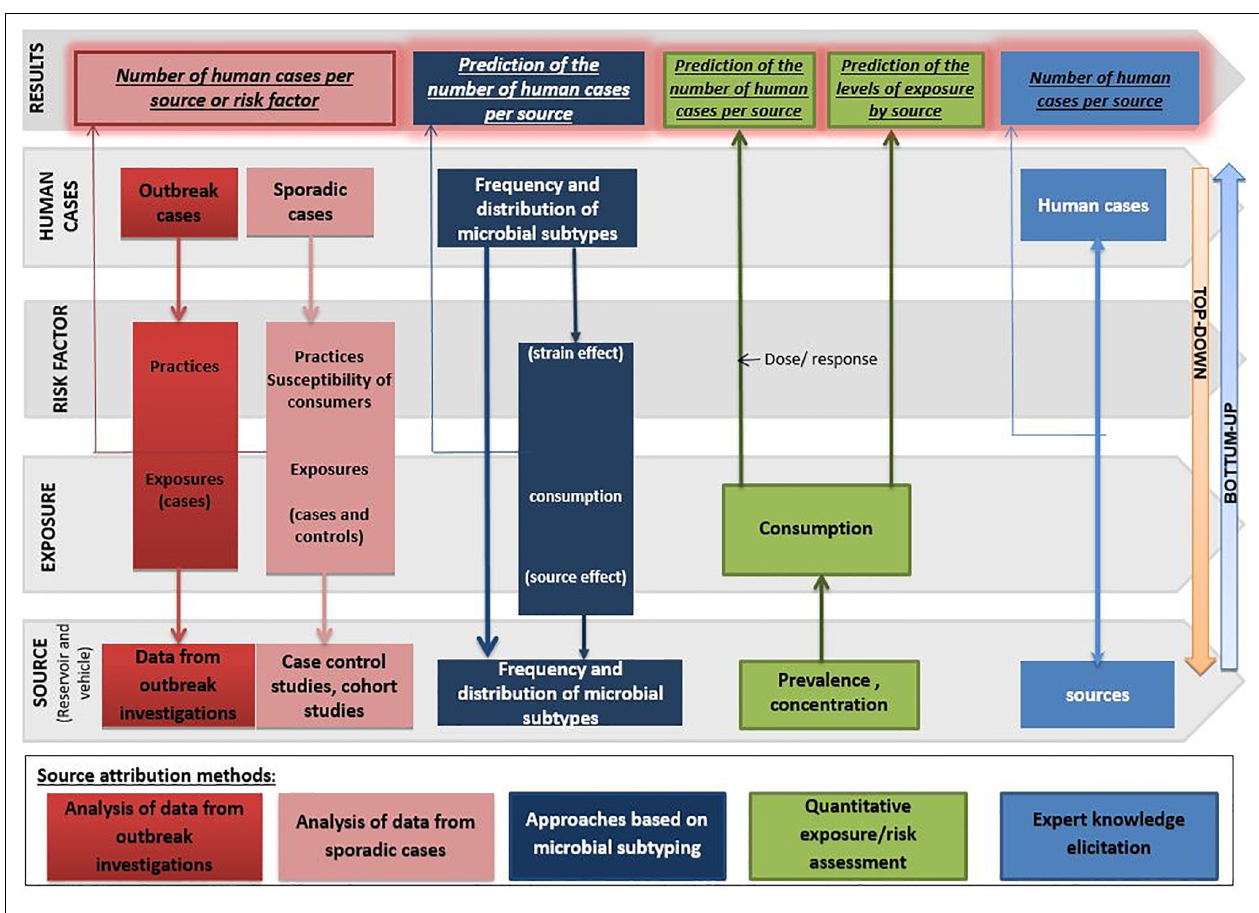
FIGURE 1 | General overview of the different source attribution approaches for foodborne